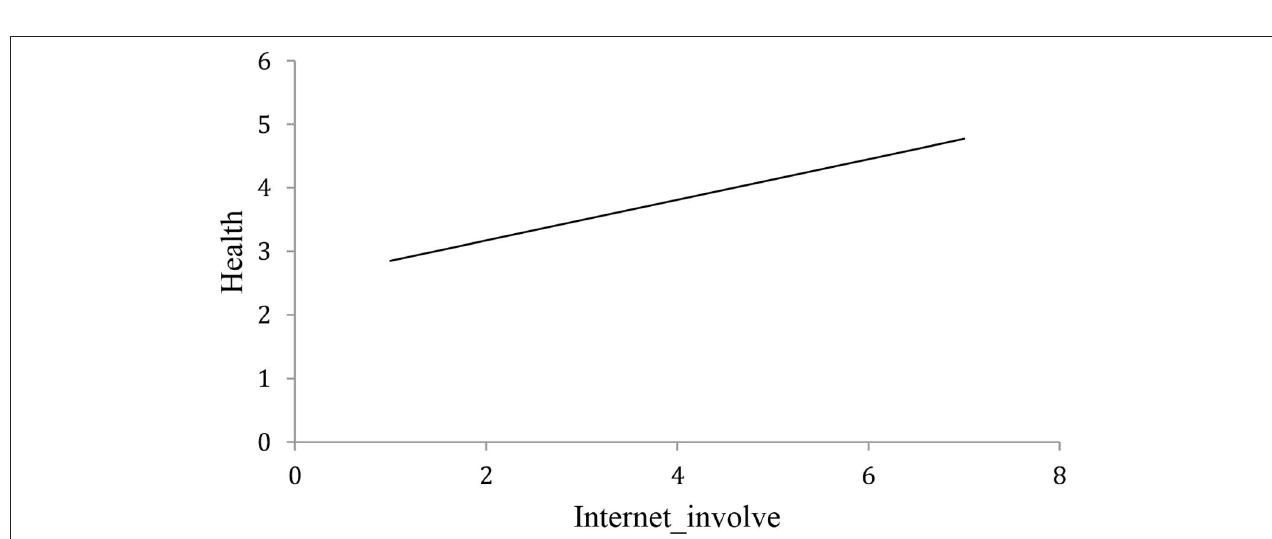
FIGURE 2 | Relationship between internet involvement and cognitive health of middle-aged and elderly people (horizontal axis shows internet involvement, vertical axis shows cognitive